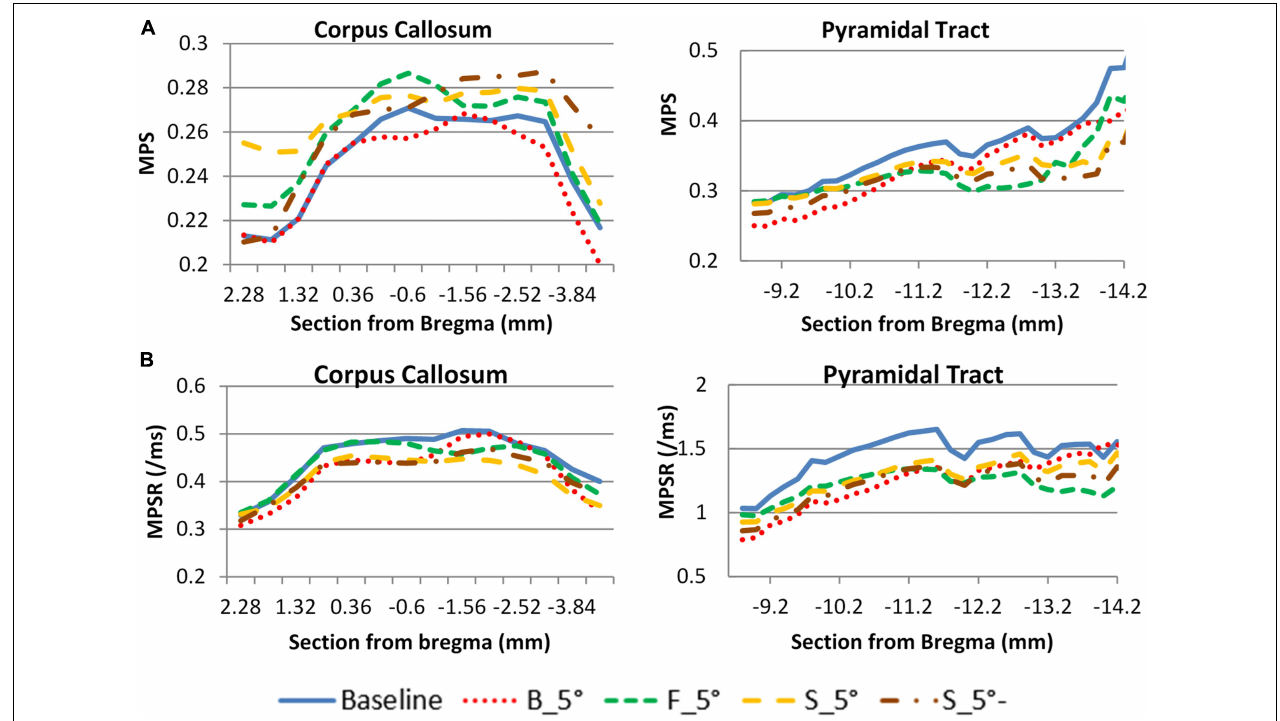
FIGURE 8 | Helmet angle effect on strain comparison at two white matter structures. (A) maximum principal strain (B) maximum principal strain rate (PS. S_5 ◦ - is the MPS/MPSR response of the other side of hemisphere of S_5 ◦ case).